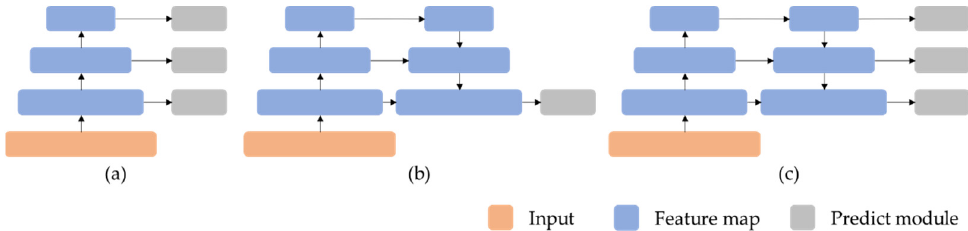
Figure 2. ( a ) Multi-scale feature prediction; ( b ) multi-scale feature fusion + single-scale feature prediction; ( c ) multi-scale feature fusion + multi-scale feature prediction.